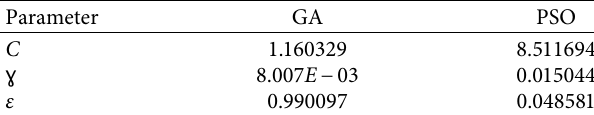
Table 5: The optimized hyper-parameters of SVR by PSO and